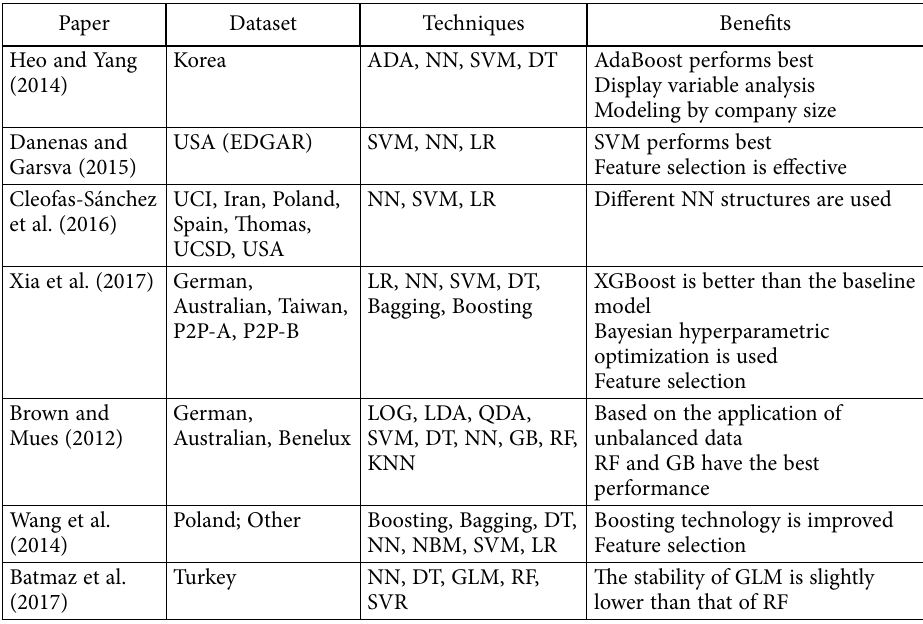
Table 1. List of different models that have good performance Paper Dataset